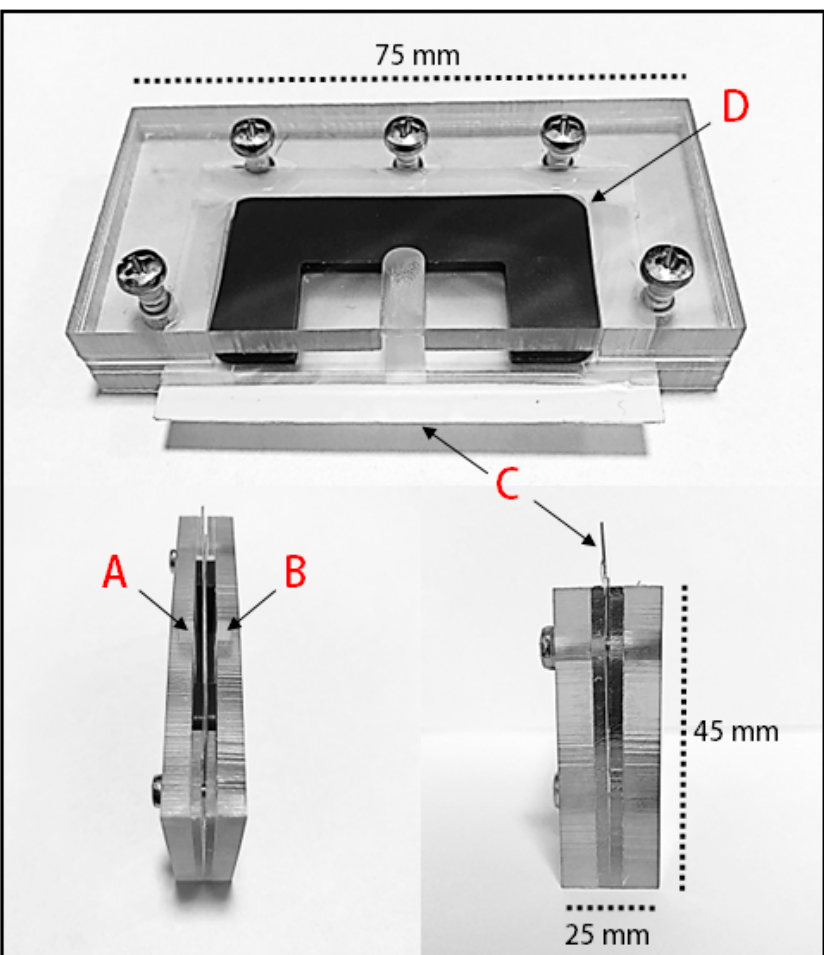
Figure 1. Sperm isolation in the Samson™ system consists of (A) a sample chamber and (B) a reaction chamber encased in an acrylic frame, separated by (C) a 5 µ m polycarbonate filter and (D) silicone seal. 0.5 mL of SpermSafe (E)™ and 0.5 mg/mL WST-1 were deposited into the reaction chamber,